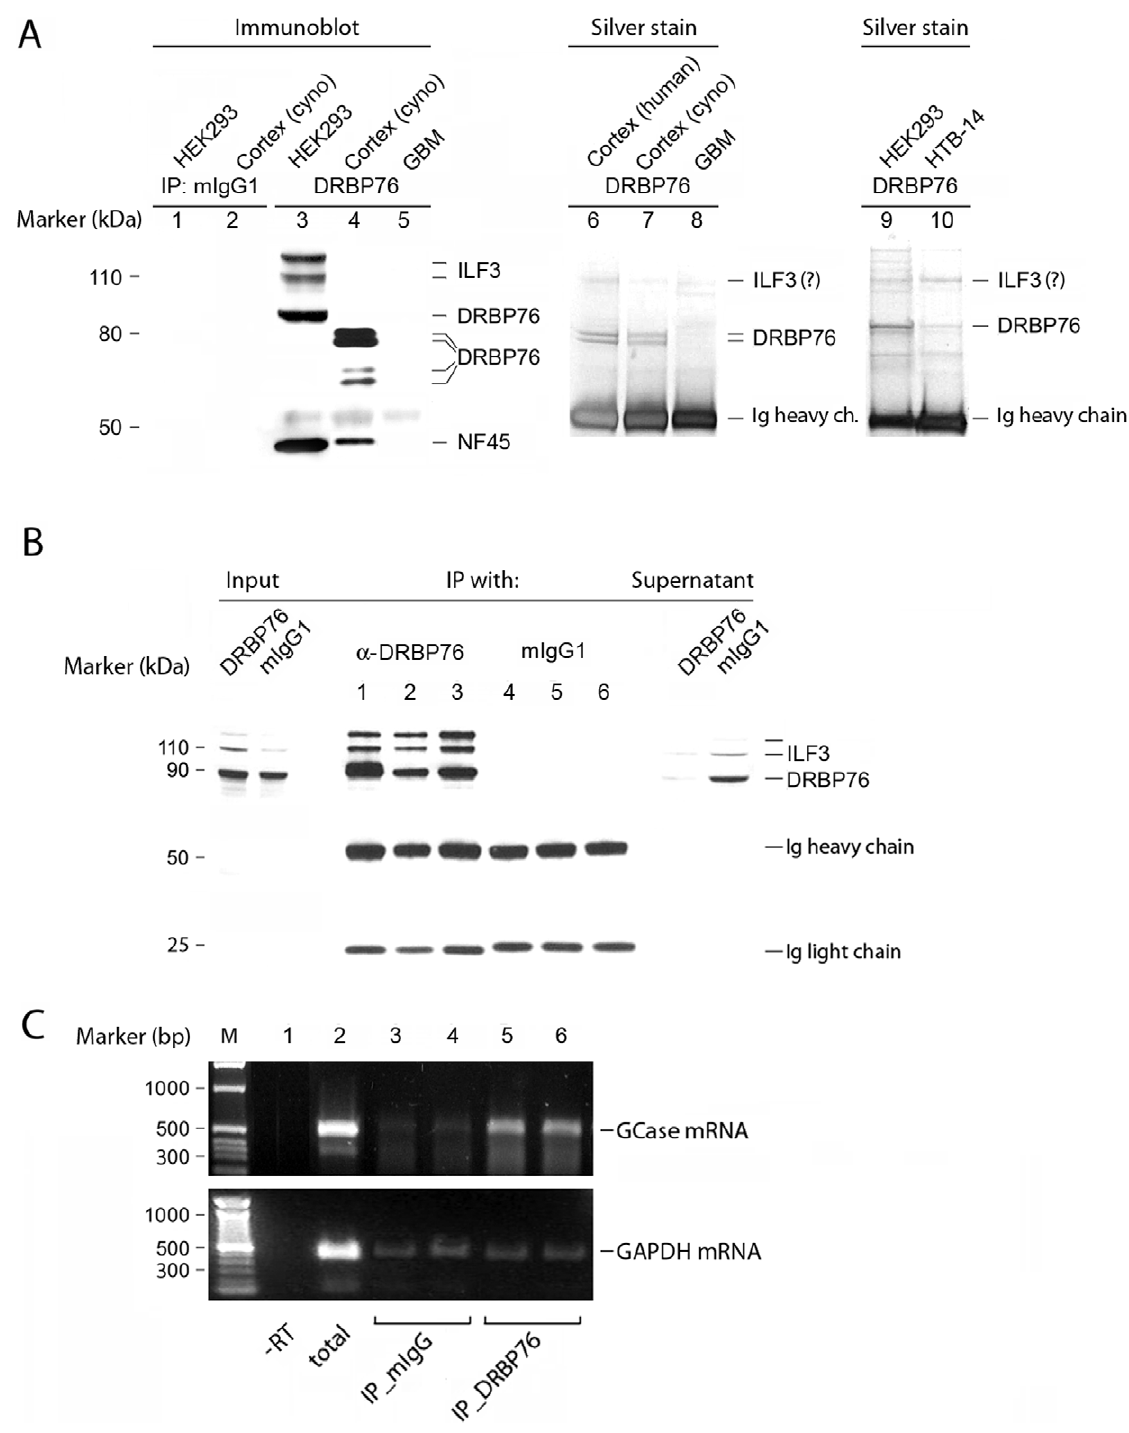
Figure 3. Immunoprecipitation studies of DRBP76. A . Left panel. Control mouse IgG and anti-DRBP76 IP from HEK293 cells, normal primate CNS and GBM tissues. Co-IP of NF45 was analyzed as well. Middle/Right panel. Silver stain of anti-DRBP76 immunoprecipitated material from normal human/simian brain and from HEK293 and HTB-14 cell lines, respectively, analyzed by immunoblot. B . IP with anti-DRBP76, but not isotype-matched control IgG, effectively removes DRBP76 from HEK293 cell lysates. C . RT-PCR of GCase and GAPDH transcript from RNA isolated from immunoprecipitated DRBP76 RNP. doi:10.1371/journal.pone.0011710.g003 detected in CNS tumors. We thoroughly evaluated DRBP76 IPs and the yield and quality of the mRNP co-precipitate, we had to from lysates obtained from monkey and human brain. Due to abandon this approach. Since the characteristic DRBP76 isoform technical difficulties regarding yield and purity of the IP reactions distribution in normal tissues is not recapitulated in transformed